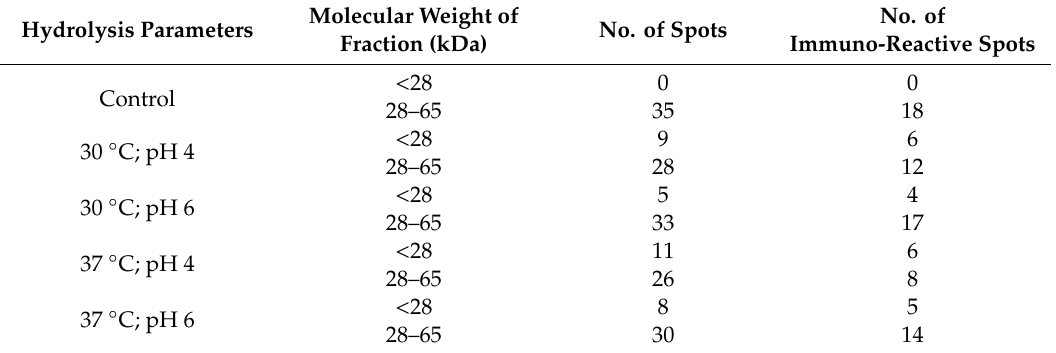
Table 3. E ff ect of reaction conditions on the number of spots before and after immunodetection of native gliadins (control) and products of hydrolysis by a mixture of peptidases from L. acidophilus 5e2 and A. niger after a 3 h